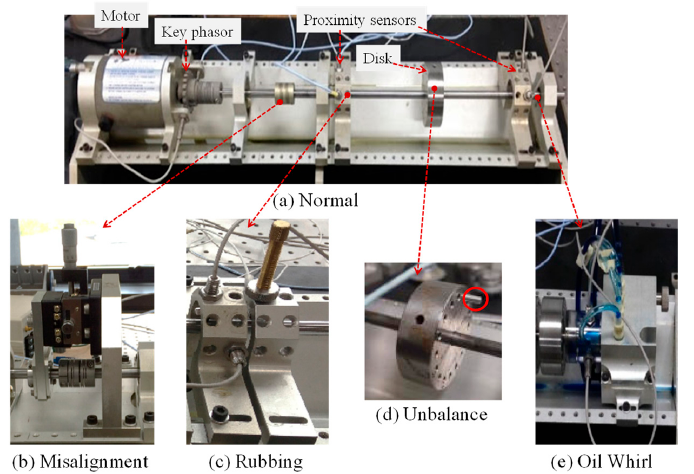
Figure 9. RK4 Rotor kit with different health states; ( a ) Normal; ( b ) Misalignment; ( c ) Rubbing; ( d ) Unbalance; ( e ) Oil